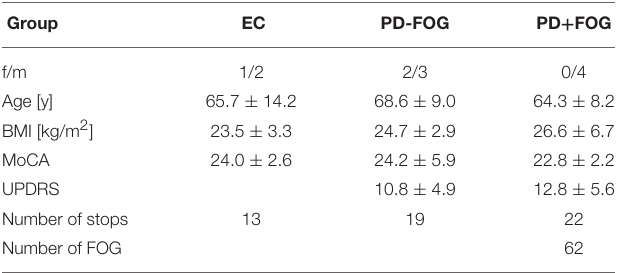
TABLE 1 | Demographic and clinical data of the study cohorts: Elderly controls (EC), participants with PD that do not show freezing-of-gait (PD − FOG), and participants with PD and freezing-of-gait (PD +